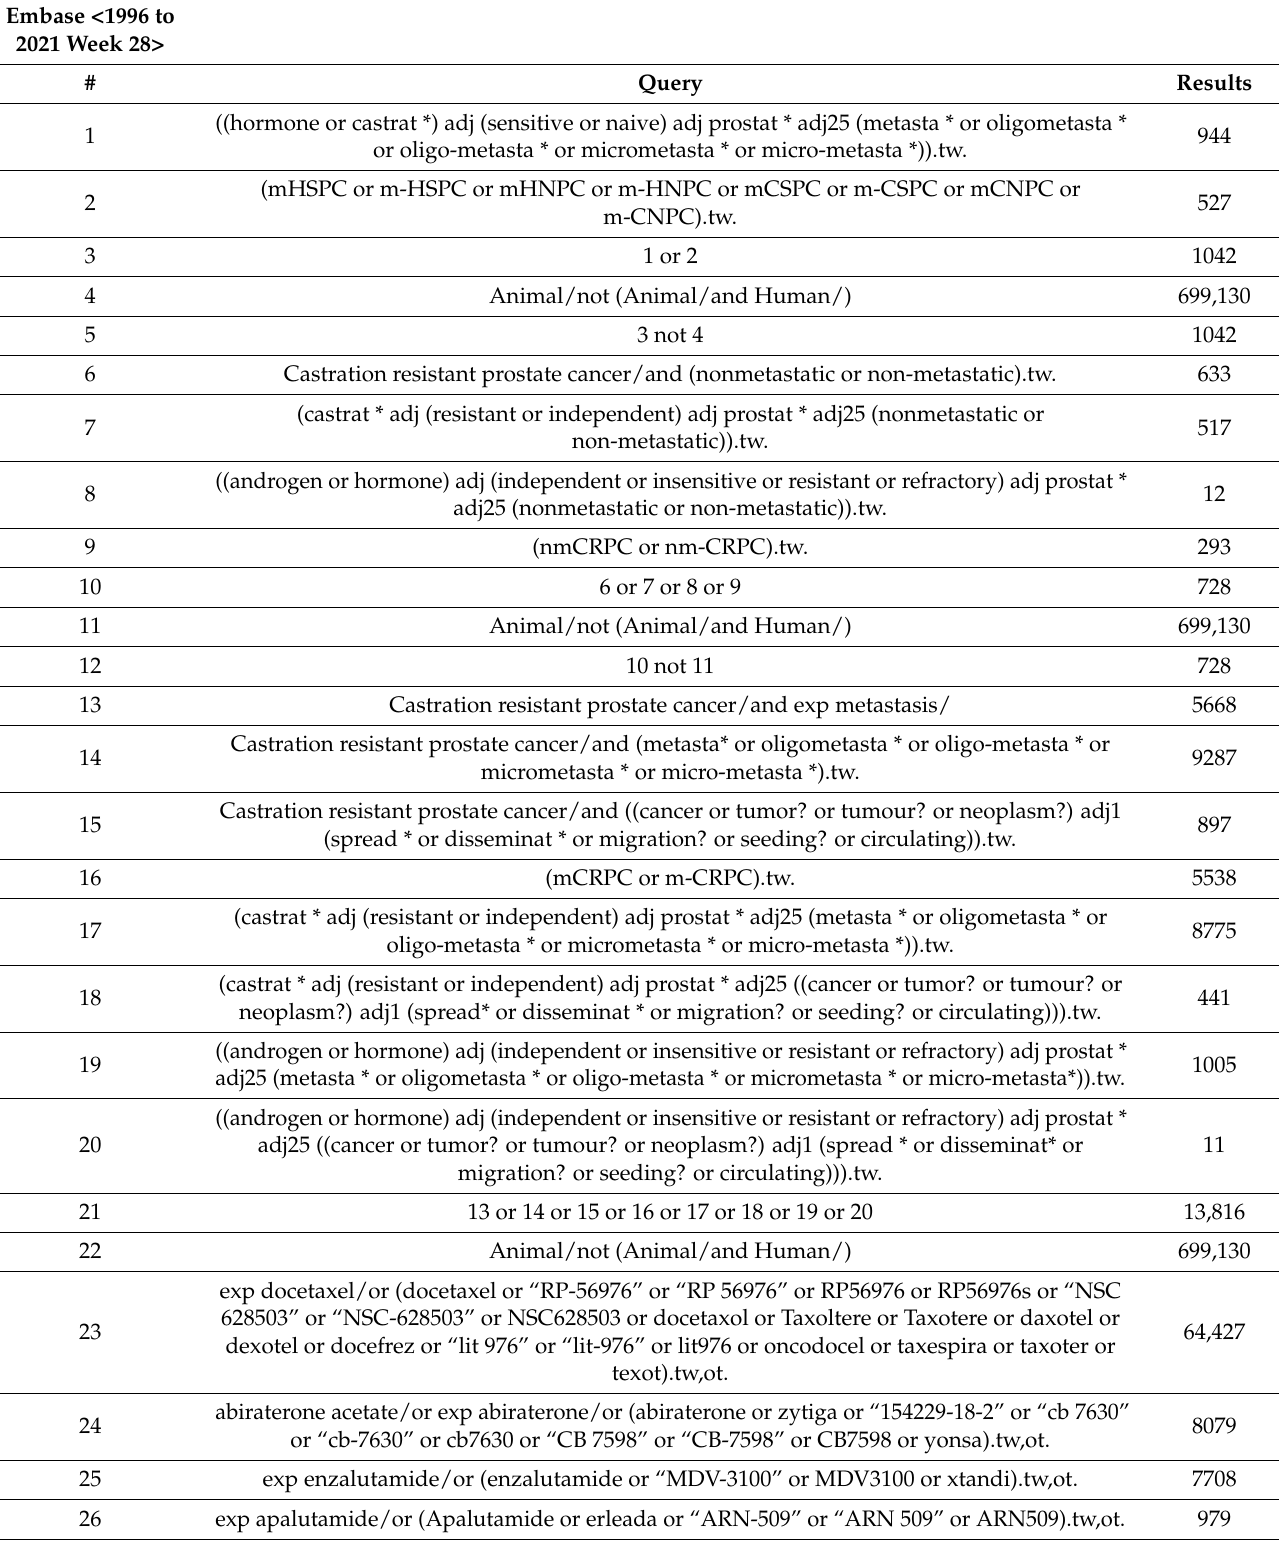
Table A1. Search strategy for Embase (searched on Thursday, 22 July 2021 8:20:33